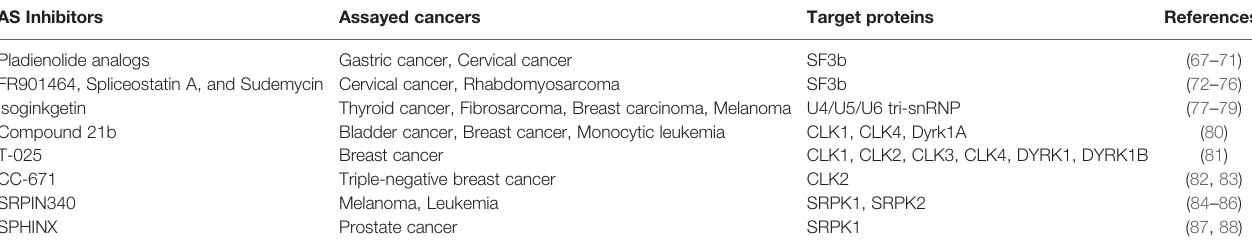
TABLE 1 | Spliceosome